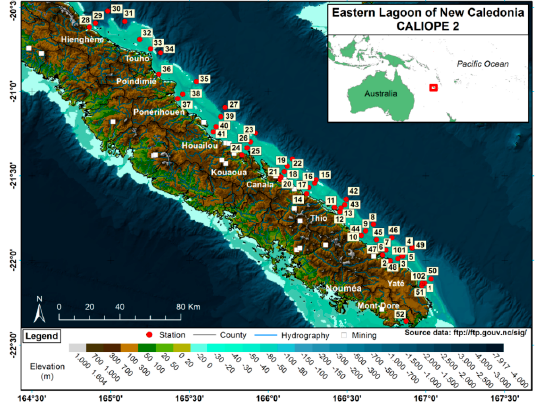
Figure 1. Map of the study area indicating the location of the sampling stations from the CALIOPE 2 conducted from 8 to 21 of March 2014 in the Eastern Lagoon of New Caledonia (ELNC). Data from bathymetry, hydrography, villages, and mining sites were downloaded from ftp://ftp.gouv.nc/sig/ accessed on 5 February